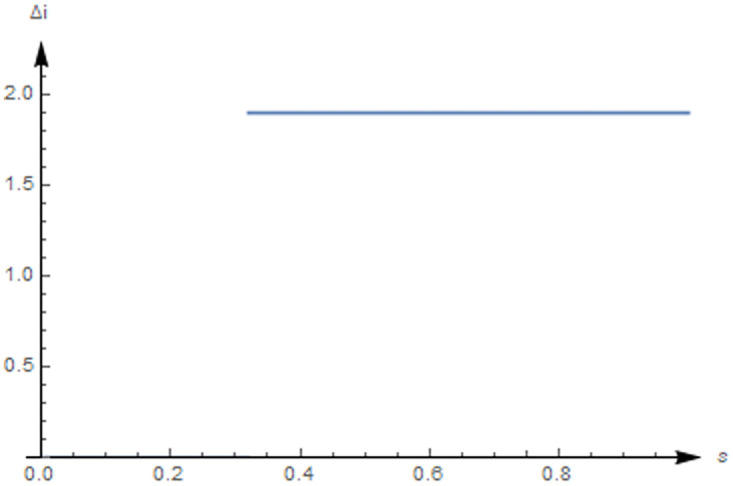
The crowding-in effect when iqq < 0.